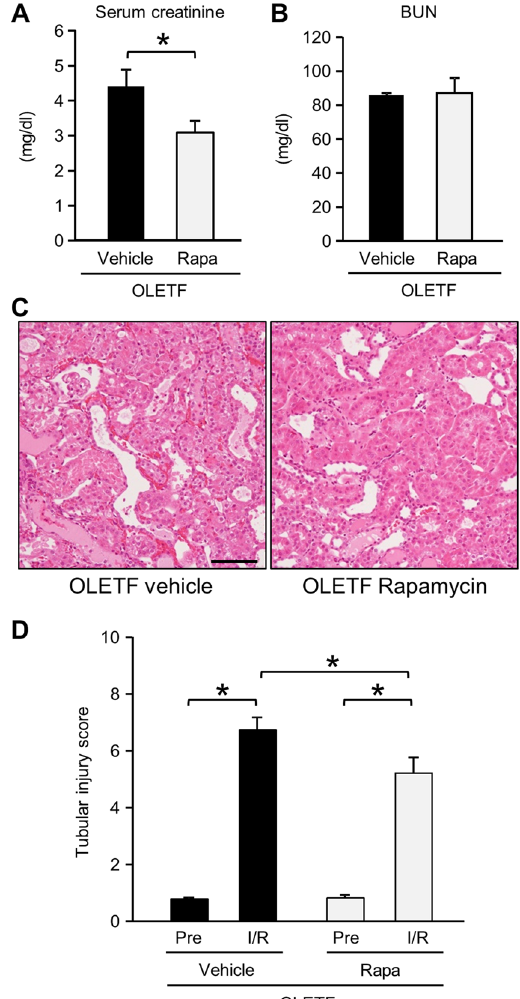
Figure 6. Effects of rapamycin on kidney injury after ischemia/reperfusion in OLETF. Levels of serum creatinine ( A ) and blood urea nitrogen (BUN) ( B ) 24 h after renal ischemia/reperfusion in OLETF treated with a vehicle (N = 7) or rapamycin (Rapa, 0.25 mg/kg, N = 7) 30 min prior to ischemia in OLETF. ( C ) Representative images of hematoxylin-eosin staining of renal tissues at 24 h after ischemia/reperfusion. ( D ) Tubular injury score before ischemia and 24 h after reperfusion in OLETF treated with vehicle or rapamycin. Pre: pre-ischemia, I/R: 24 h after ischemia/reperfusion. * P < 0.05. Scale bar, 100 μ